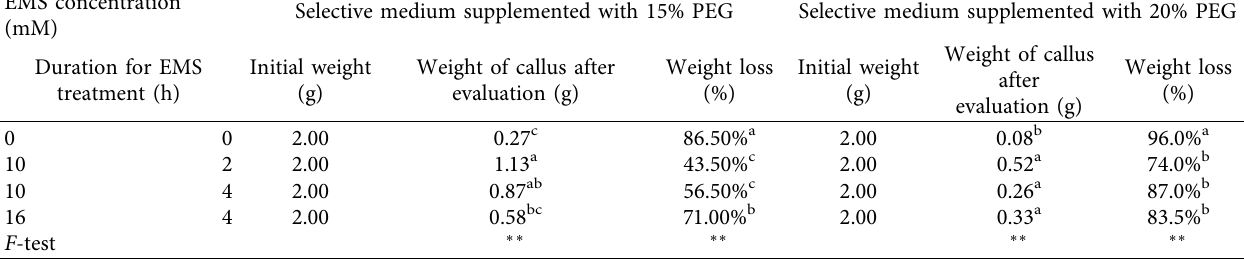
Table 3: Growth and development evaluation of ethyl methanesulfonate (EMS) treated calli on selective medium supplemented with 15% or 20% PEG for 4 weeks.